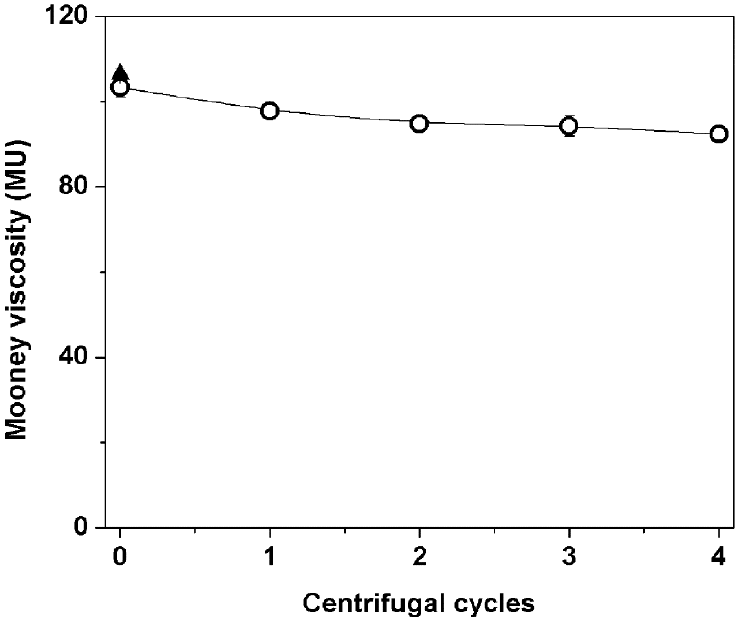
Figure 4. Mooney viscosity of HANR and DPNRs.